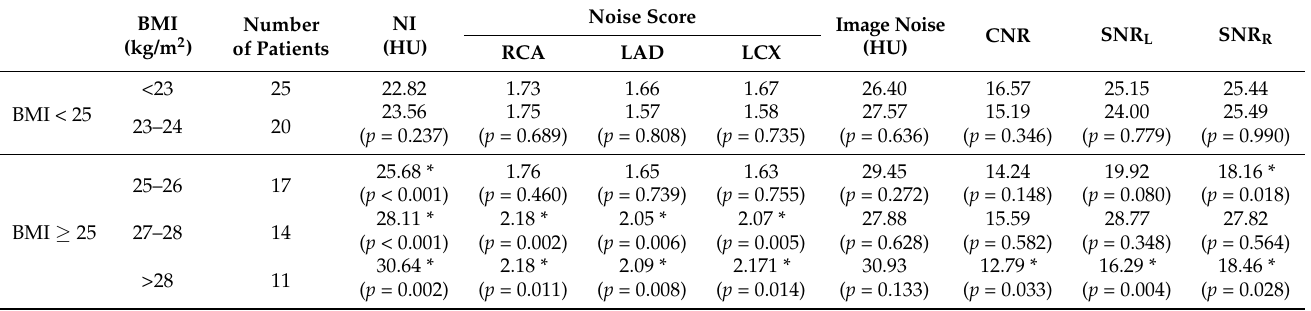
Table 3. Comparison of NI, subjective image quality score, and objective noise measurements in different BMI groups.